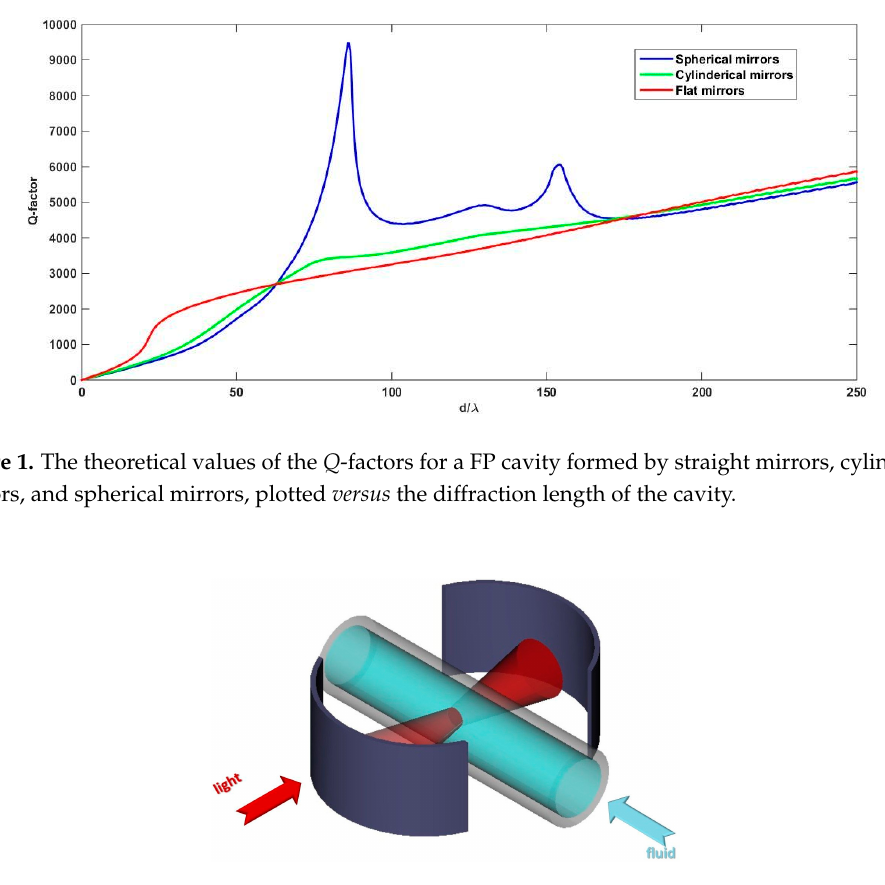
Figure 3. Schematic diagram for: ( a ) the horizontal cross section and ( b ) the vertical cross section, of the cylindrical Fabry-Pérot cavity with the micro tube inside indicating the design parameters and geometry.